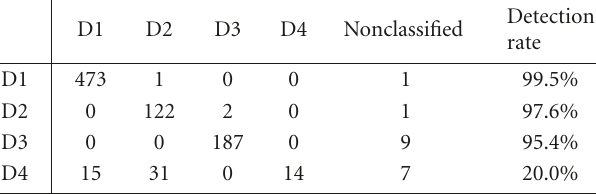
Table 7: Classification results for data from network B, where the SVM is trained with data from network A and synthetic